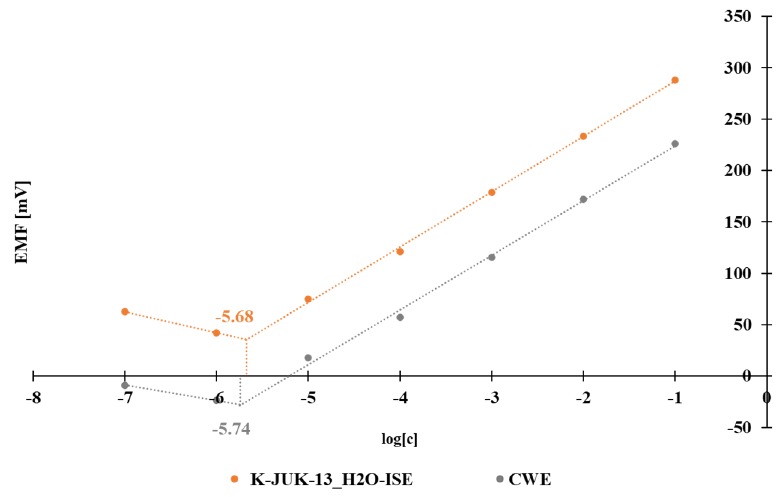
Figure 3. Determination of the limit of detection for K-MOF-ISE and CWE.